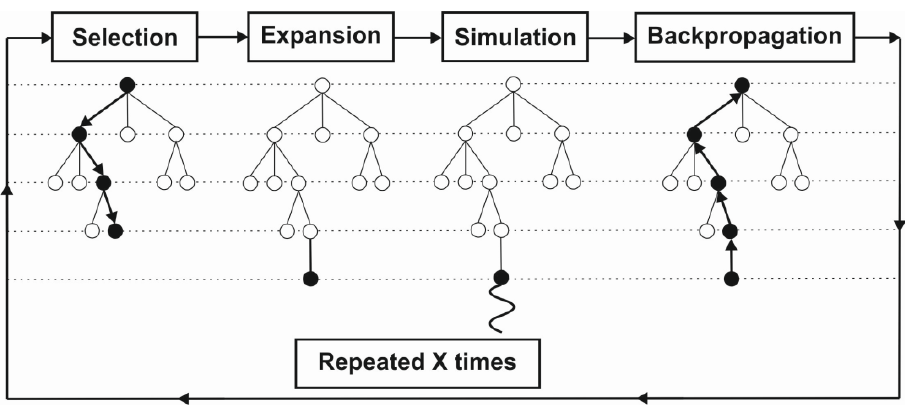
Figure 3. Example of a Monte Carlo tree search. Source: Own study based on [69].